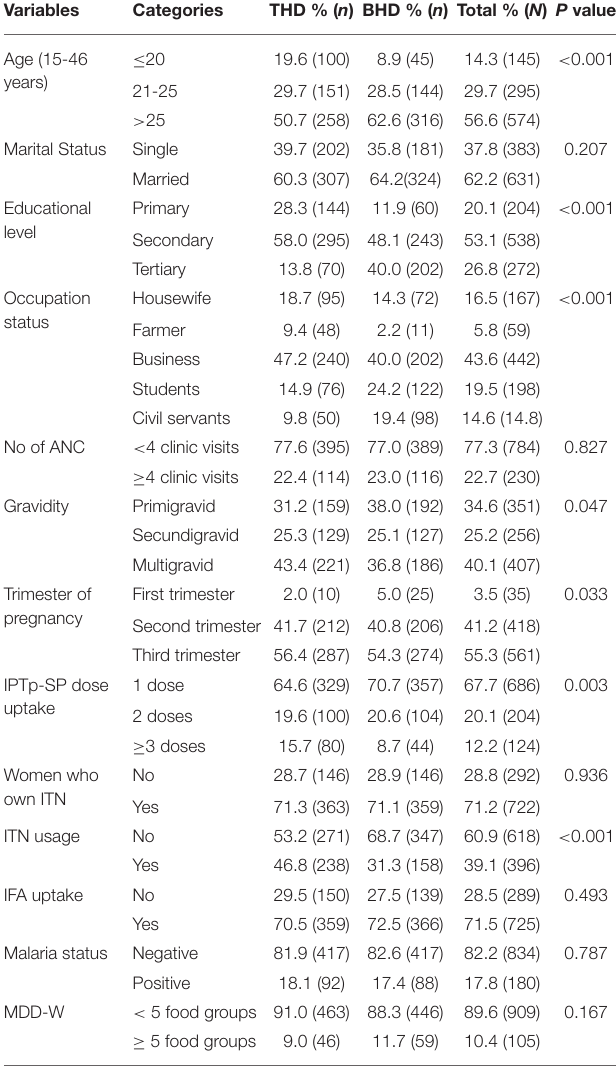
TABLE 1 | Baseline characteristics of the study population per study setting.